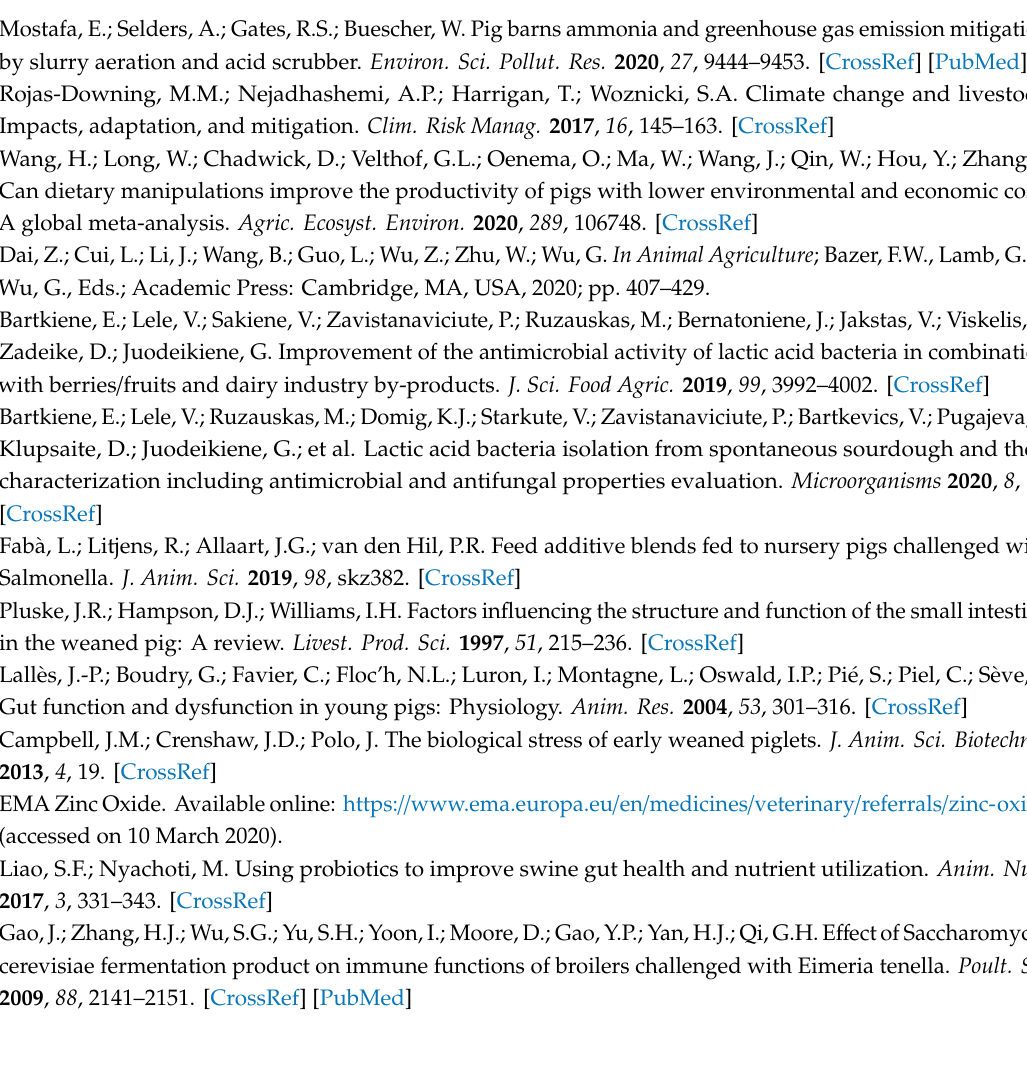
Table S1: Control group species; Table S2: Experimental group species after